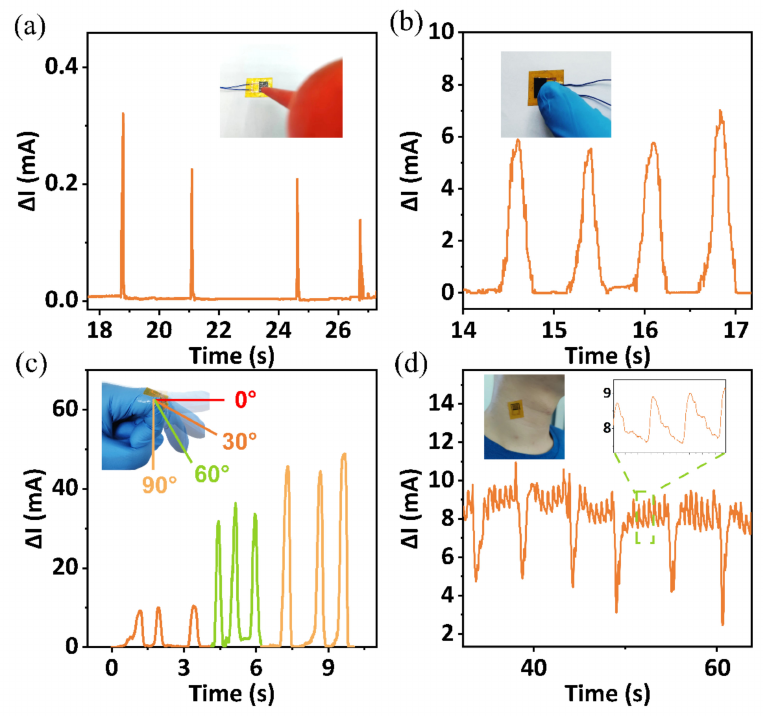
Figure 5. ( a ) The current response output of gas leak monitoring, and the image is shown in the inset; ( b ) the response of touching; ( c ) the response of bending the finger; ( d ) the monitoring of swallowing and carotid pulse.